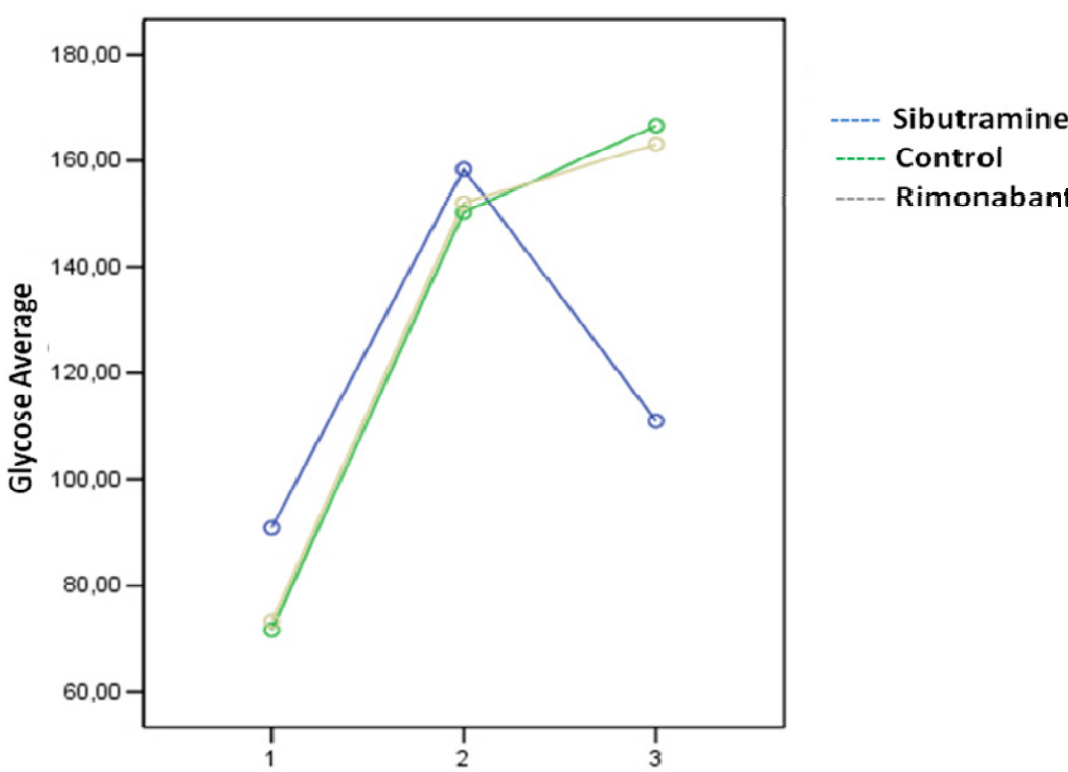
FIGURE 2 - Glycose comparison at the three phases of the study. There was significant decrease in Sibutramine